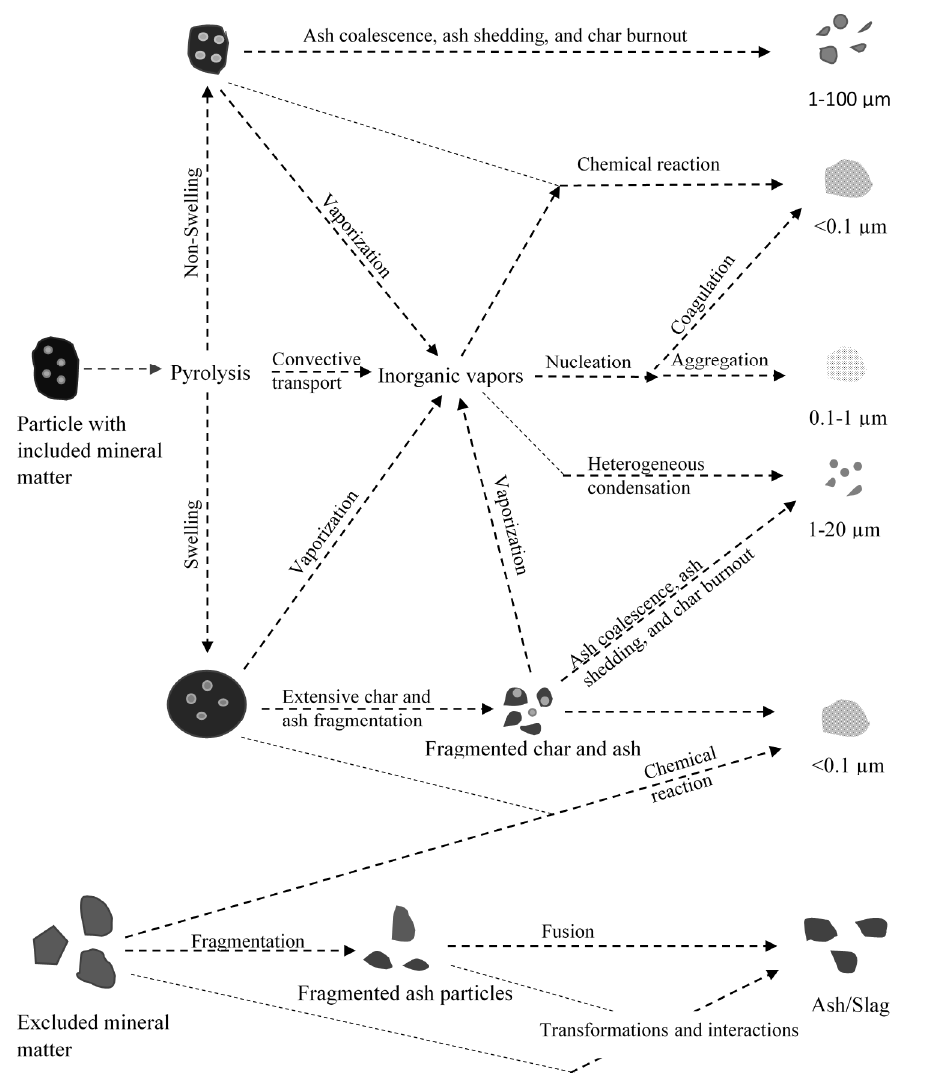
Figure 7. Mineral matter transformations of pulverized coal particles in an entrained flow gasifier (Modified after Wu et al.